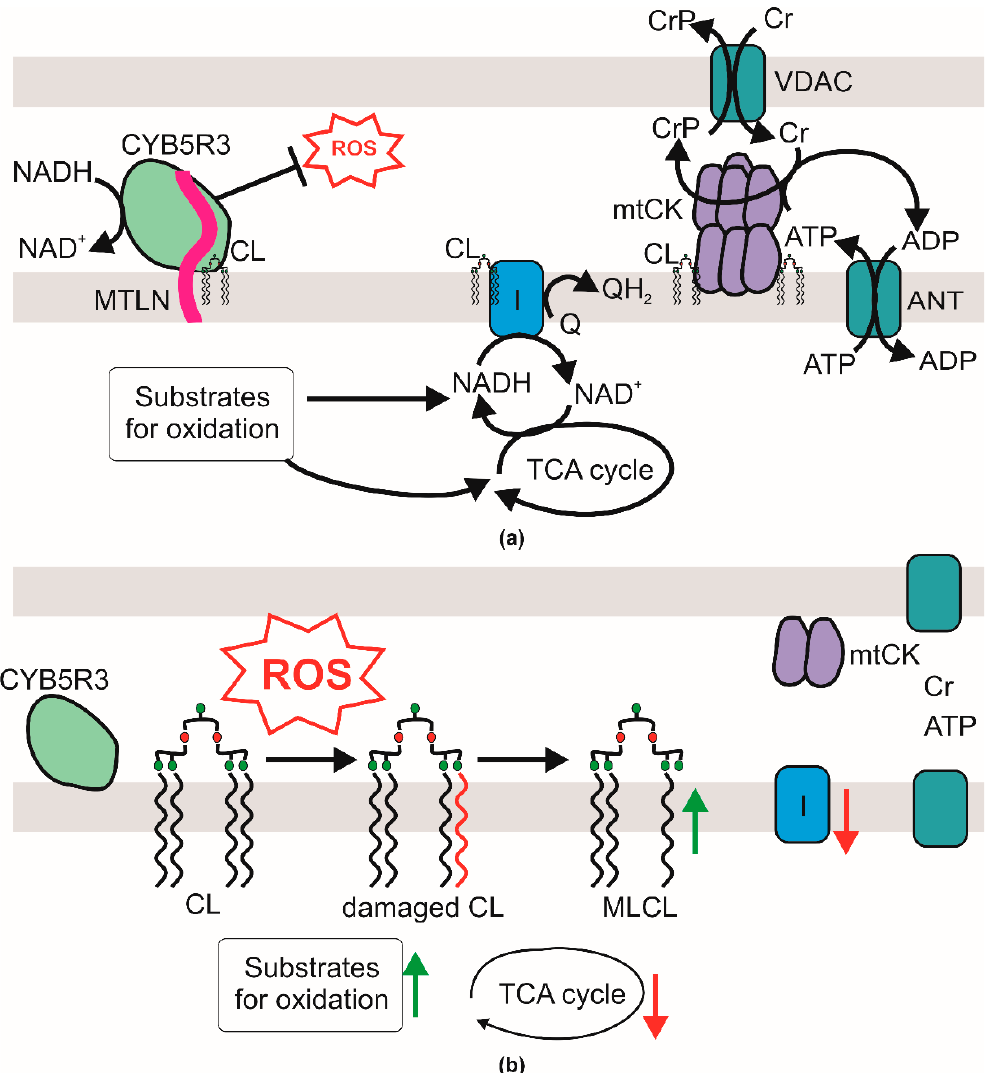
Figure 5. A model for the Mtln function. ( a ) Mitochondrial homeostasis in the presence of intact Mtln. Shown is an interaction of Mtln (pink) with cardiolipin (CL) and CYB5R3 NADH dehydrogenase preventing oxidative lipid damage by the reactive oxygen species (ROS). It ensures normal CL concentration and proper activity of the respiratory complex I (I). The tricarboxylic acids (TCA) cycle functions normally and ensures oxidation of substrates. Cardiolipin facilitates mitochondrial creatine kinase (mtCK) octamerization in the intermembrane space coupling ATP/ADP antiporter (ANT) activity, creatine (Cr) phosphorylation and creatine phosphate (CrP) export to the cytosol via VDAC. ( b ) Consequences of Mtln inactivation. Lack of Mtln leads to a loss of its interaction with CL and increased ROS production, likely due to the decreased CYB5R3 activity. Increased concentra-